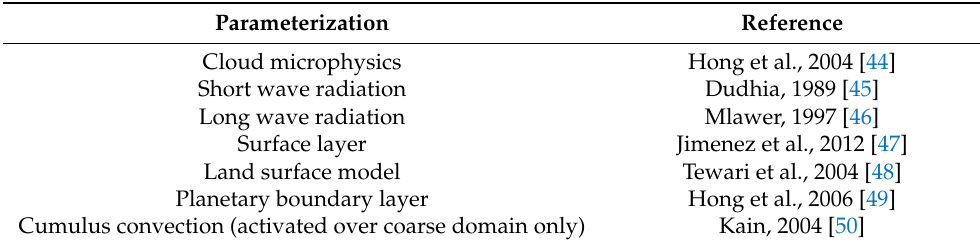
Table 1. Parameterizations schemes used for the WRF meteorological